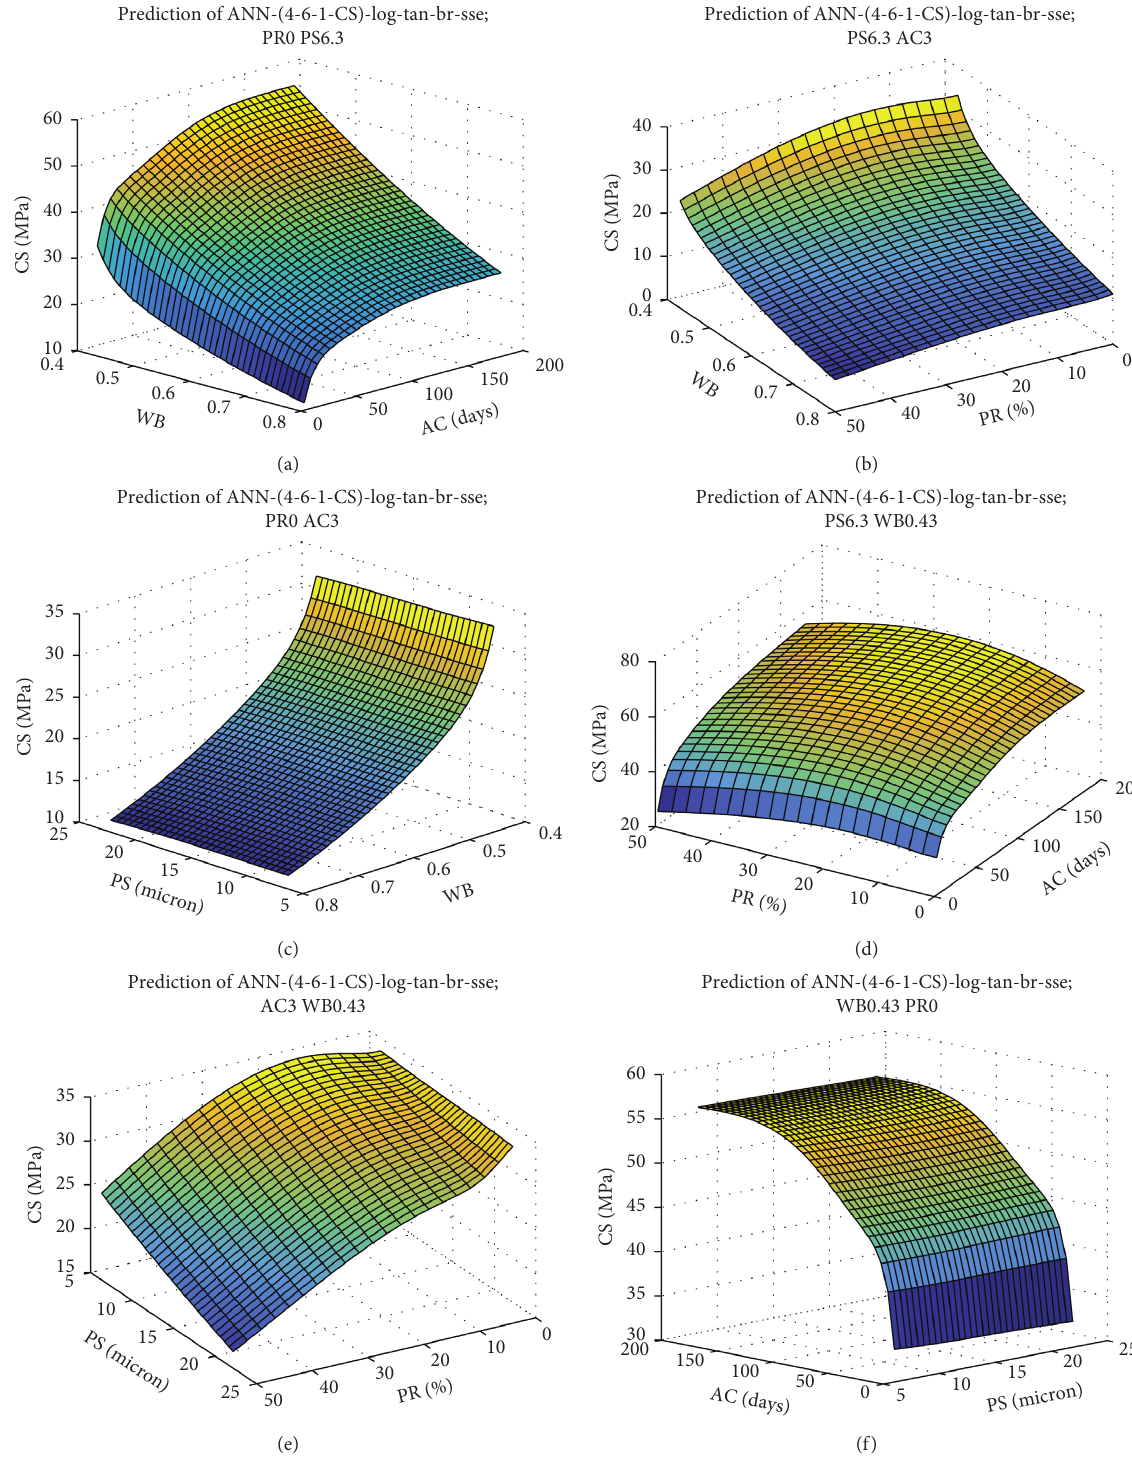
Figure 5: The 3D plots of predictive results of the optimal ANN models with the factor parameter of WB � 0.43, PR � 0, PS � 6.3, and AC � 3. (a) PR � 0 and PS � 6.3. (b) PS � 6.3 and AC � 3. (c) PR � 0 and AC � 3. (d) WB � 0.43 and PS � 6.3. (e) WB � 0.43 and AC � 3. (f) WB � 0.43 and PR �